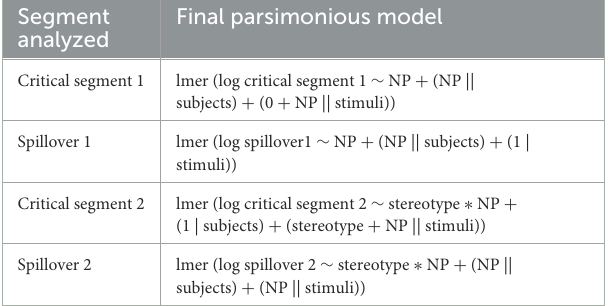
Table 6. The details of model selection and comparison are available at